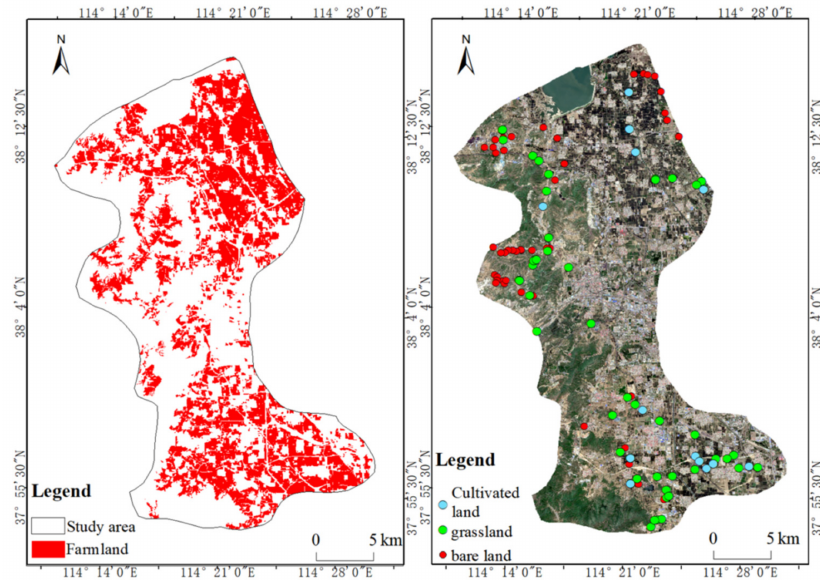
Figure 2. Farmland and field survey data in the study area.